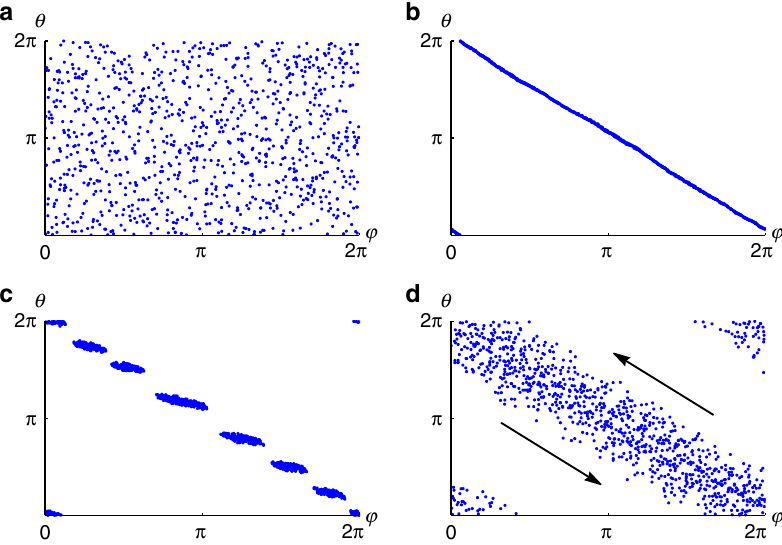
Fig. 3 Scatter plots in ( ϕ , θ ) space. Distributions in ( ϕ , θ ) space corresponding to different states, where ϕ ¼ tan (cid:2) 1 ð y = x Þ . Simulations were run with N = 1000 swarmalators for variable numbers of time units T and stepsize dt = 0.1. a Static async state for ( J , K ) = (0.1, − 1) and T = 100. b Static phase wave state ( J , K ) = (1, 0) and T = 100. c Splintered phase wave state ( J , K ) = (1, − 0.1) and T = 1000. d Active phase wave state ( J , K ) = (1.0, − 0.75) and T = 1000. Black arrows indicate the shear fl ow motion of swarmalators. Supplementary Movies 6 and 7 correspond to panels c , d